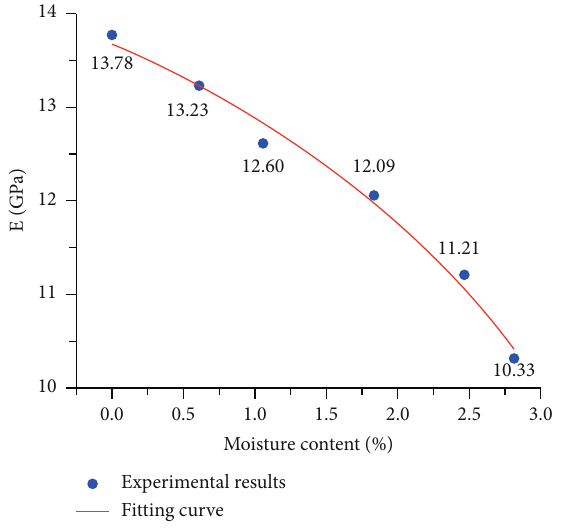
Figure 6: Relationship between E and ω . Table 3: The function and R 2 used to fit E and ω . Fitting function R 2 Polynomial fit 0.98622 Linear fit 0.97206 Exponential fit